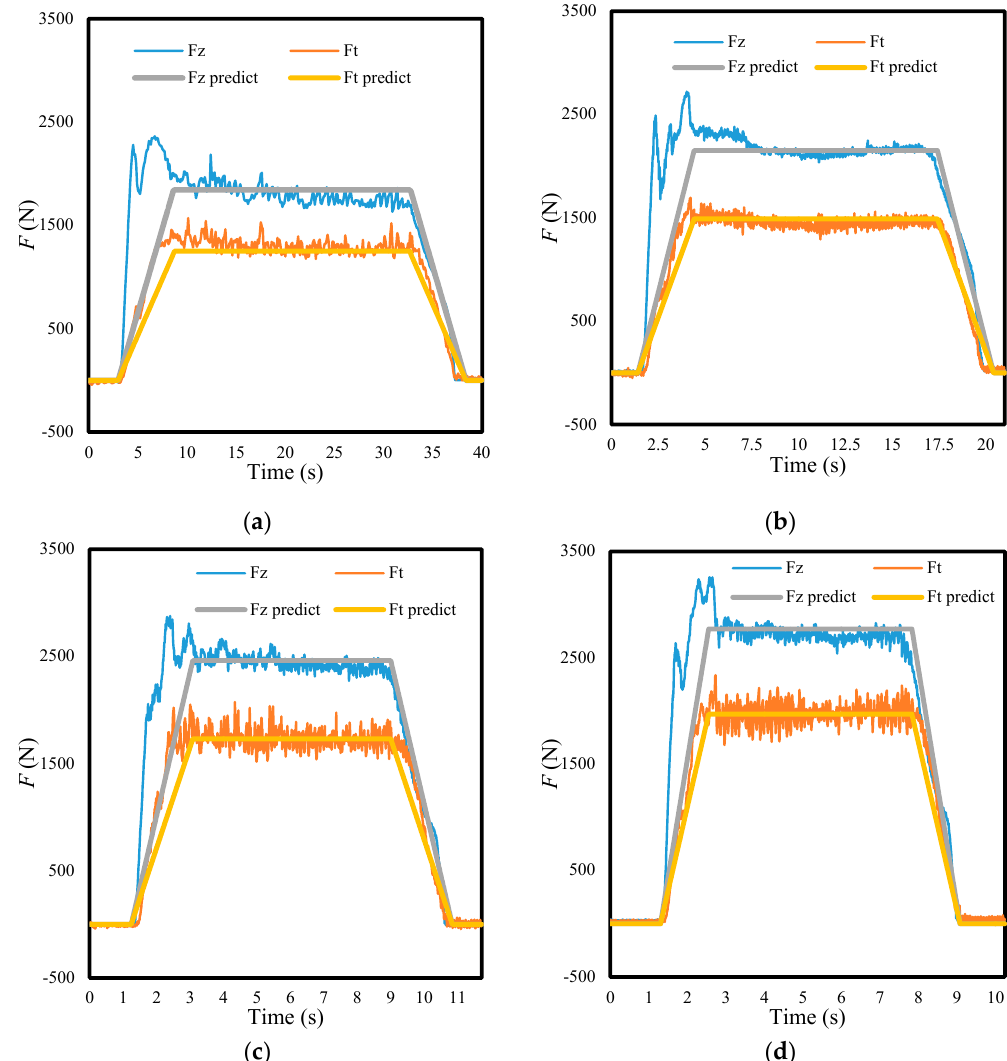
Figure 5. Comparison of predicted and experimental values of cutting force under different cutting conditions: ( a ) n = 400 rpm, f = 32 mm/min; ( b ) n = 550 rpm, f = 60 mm/min; ( c ) n = 700 rpm, f = 98mm/min; ( d ) n = 850 rpm, f = 144 mm/min.